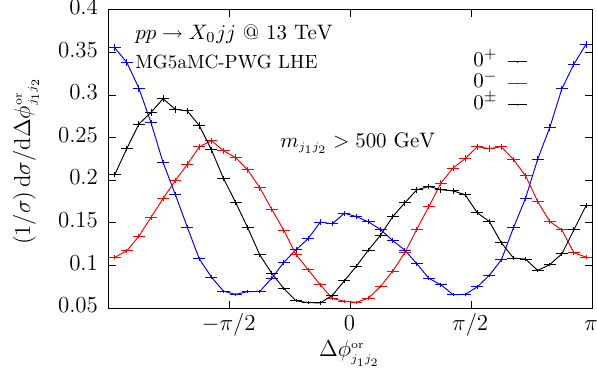
on the dijet mass, while on the right panel a cut of 500 GeV is applied. The colour code is the same as in Fig. 1